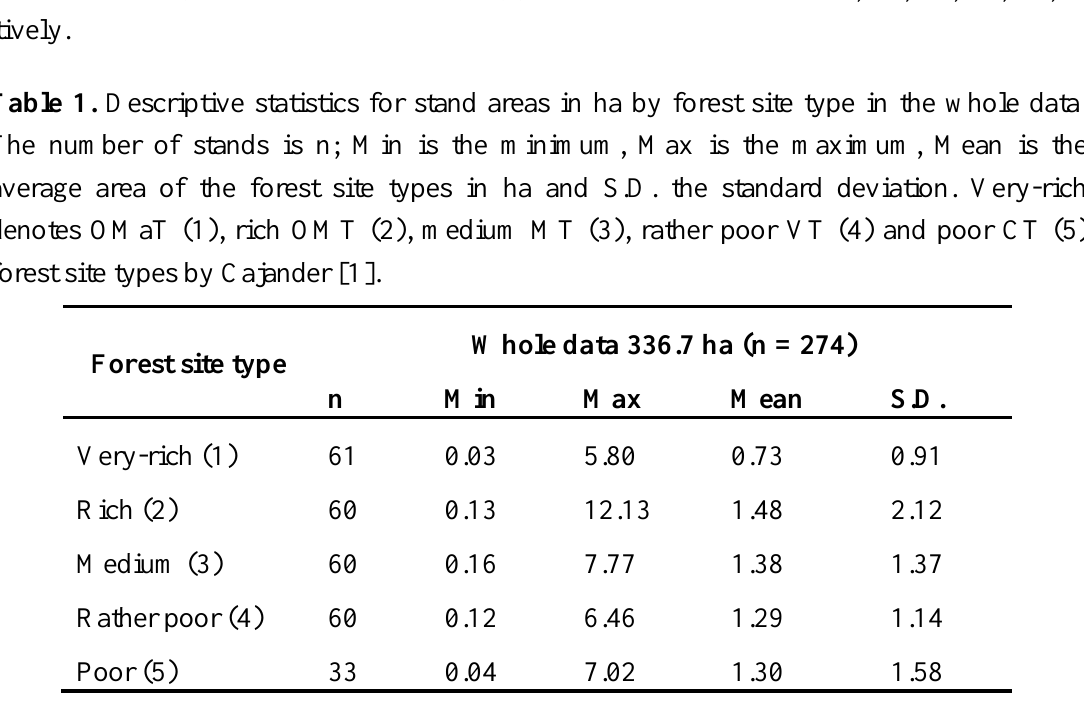
Table 1. Descriptive statistics for stand areas in ha by forest site type in the whole